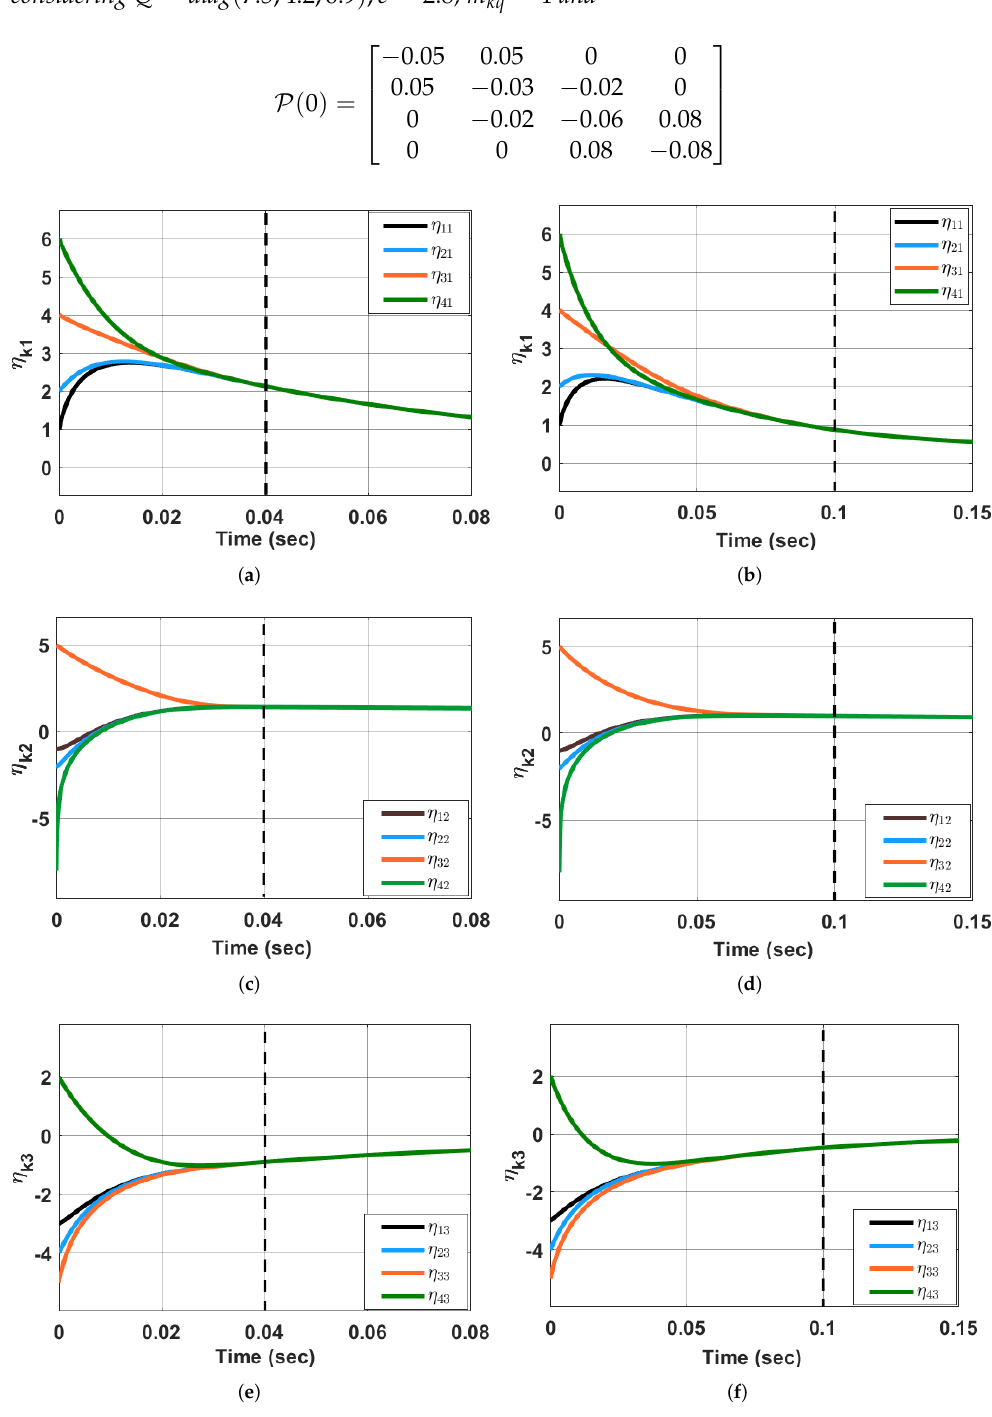
Figure 1. Synchronization of the states of MAS (1) using the control (32) (with ζ ( t ) = 0) in predefined- time τ f = 0.04 s ( a , c , e ) and τ f = 0.1 s ( b , d , f